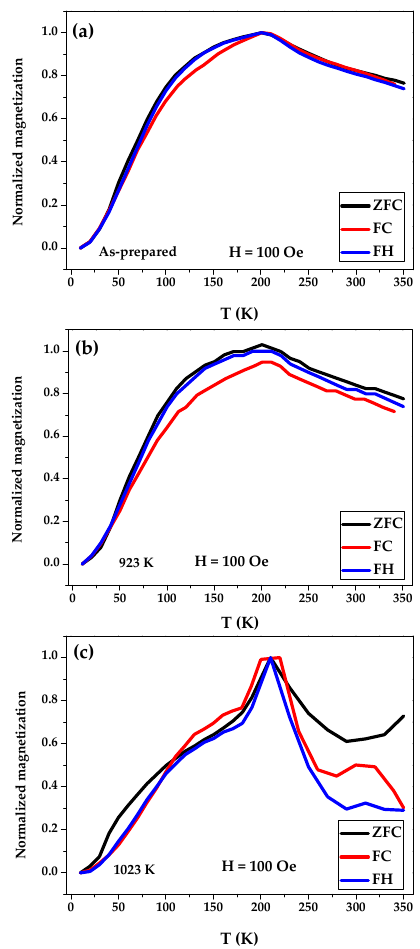
Figure 2. Zero field cooling (ZFC), field cooling (FC) and field heating (FH) of Co 2 MnSi glass-coated microwires, both as-prepared samples ( a ) and samples annealed at 923 K (2 h) and 1023 K (2 h) ( b ) and ( c ), respectively.